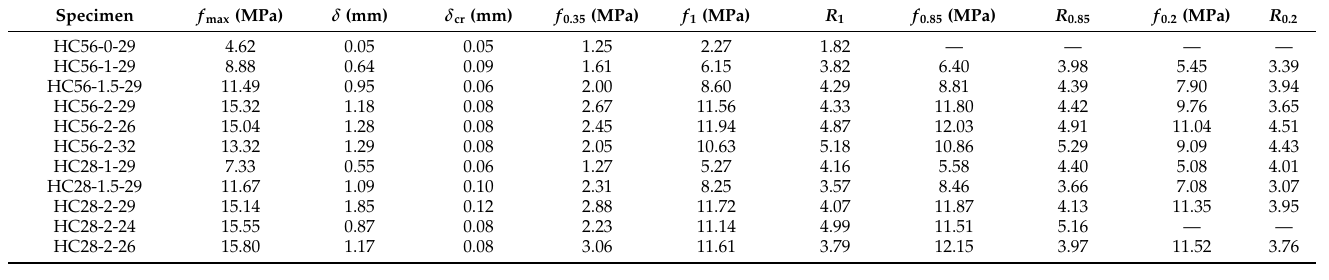
Figure 7. Effect of fiber content on load-deflection curves: ( a ) 56 d; ( b ) 28 d. It can be seen from Figure 8 that with an increase in the water–binder ratio, the energy dissipation capacity of the HDC beam gradually increased, and the corresponding deflec- tion range of its bending strength and peak load was about 10%. This was because the higher the water-to-gel ratio, the easier the fibers pulled out, which significantly increased energy consumption and deformation capacity [36]. In addition, the tensile strength of the fiber, the bond between the fiber and the matrix, and the strength of the matrix should also have a certain corresponding relationship to prevent the fiber from breaking, to en- sure the pull-out failure of the fiber at the cross-section, and to enhance the tensile strain hardening effect of the material, as well as the multi-crack development characteristics.